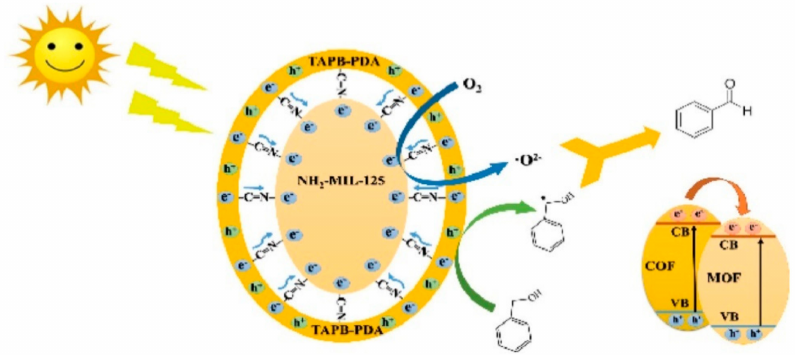
Figure 13. Scheme of bonding features and electronic properties of MOF / COF (covalent organic framework) hybrid materials and their involvement in the photooxidation of aromatic alcohols. Adapted and reprinted with permission from [225], Copyright (2020)